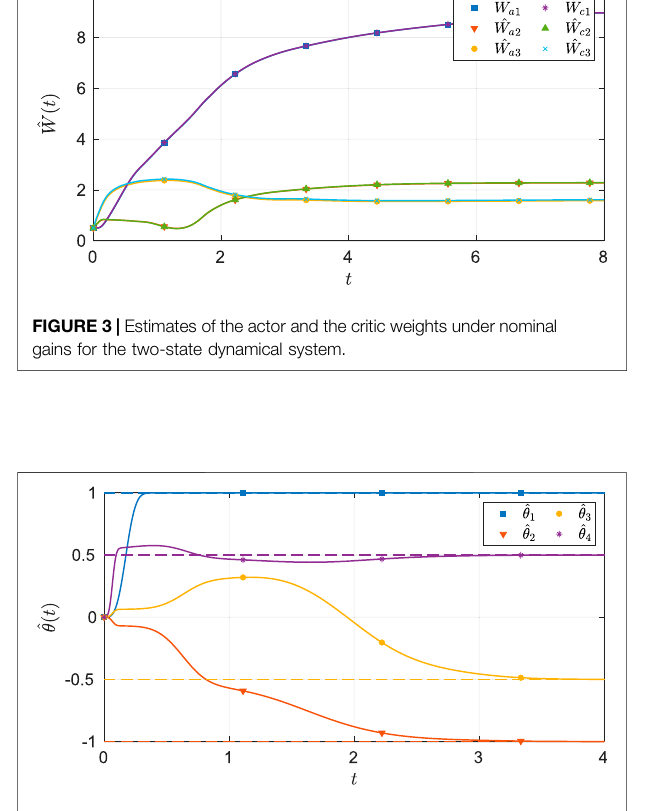
FIGURE 7 | Estimates of the critic weights under nominal gains for the four-state dynamical system.